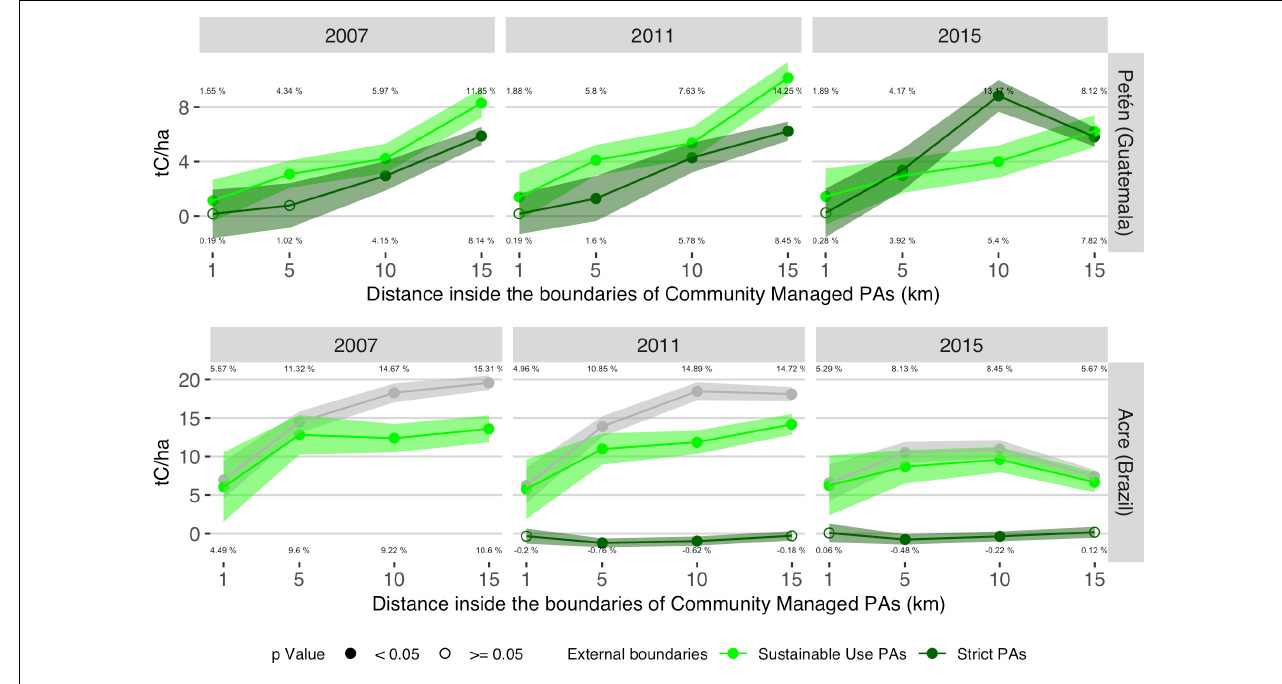
FIGURE 7 | The spatial effects of Community Managed PAs on carbon stocks during 2007, 2011, and 2015 in Petén (Guatemala) and Acre (Brazil). The points and percentages are the spatial effects, indicating the additional/fewer carbon stocks secured inside the boundaries of Community Managed PAs relative to Other Lands (gray), Sustainable Use PAs (light green), and Strict PAs (dark green).